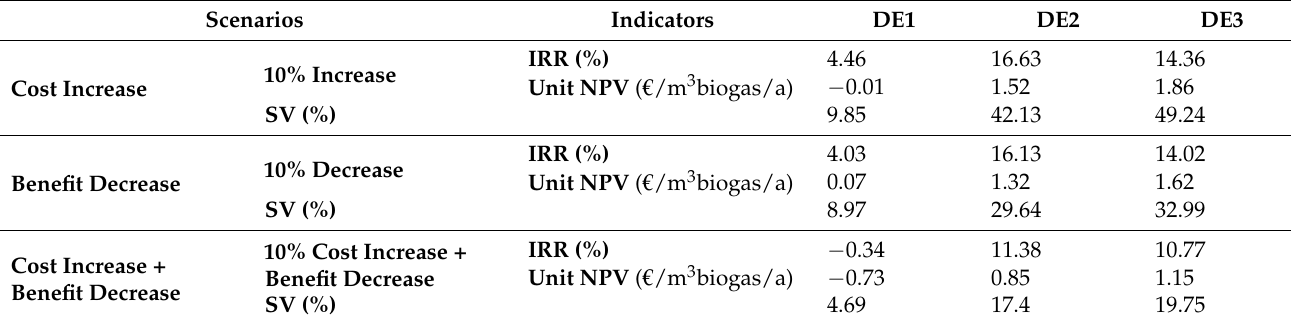
Table 6. Summary of sensitivity tests for financial analyses of German (DE) biogas plants.